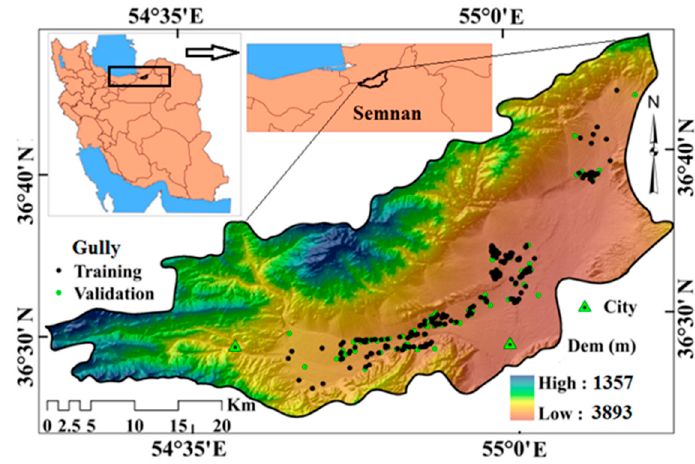
Figure 1. Location of the study area in Iran and Semnan province and locations of gullies used for training (black dots) and validation (green dots).